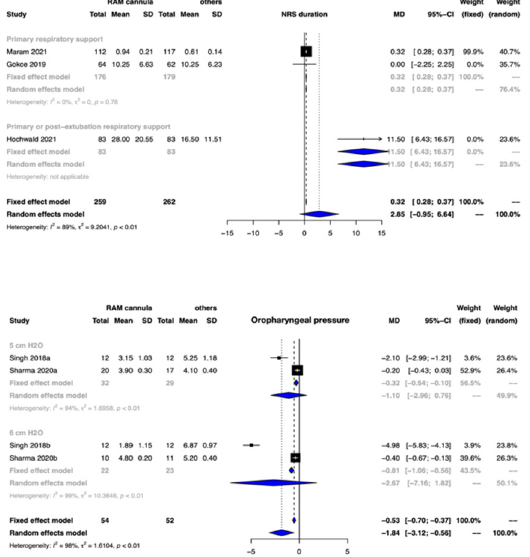
Figure 4. Forest plots depicting the effect estimates for the outcomes: noninvasive respiratory support (NRS) duration and oropharyngeal pressure